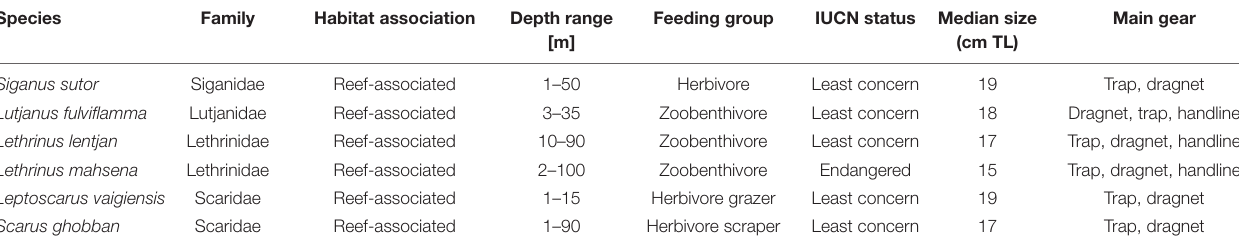
TABLE 1 | Key characteristics of the analyzed target species.